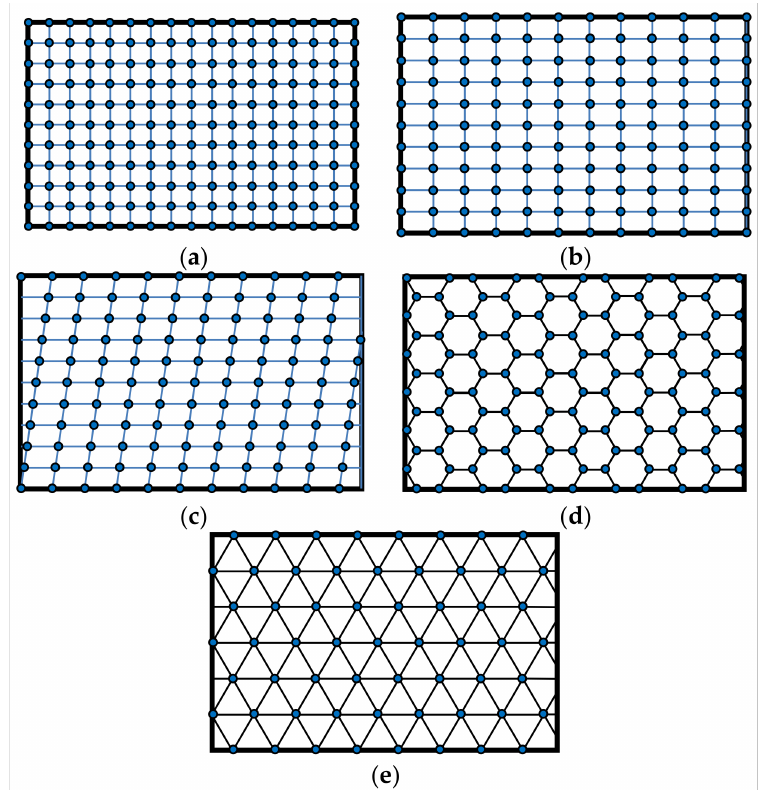
Figure 3. Five basic types of 2D Bravais spatial lattices of the electromagnetic scatterers integrated with nanomembranes: ( a ) square lattice (belongs to tetragonal group); ( b ) rectangular (orthorhombic group); ( c ) oblique (monoclinic group); ( d ) hexagonal (hexagonal group); ( e ) triangular–centered hexagonal (hexagonal group).